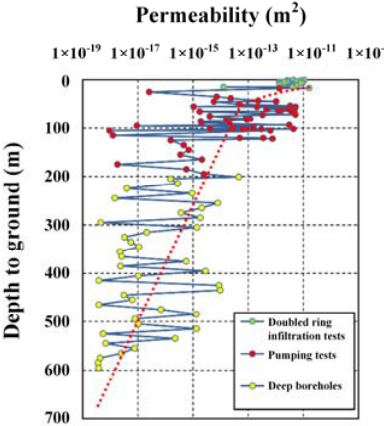
Figure 5. Change of permeability with depth to ground obtained from field tests.